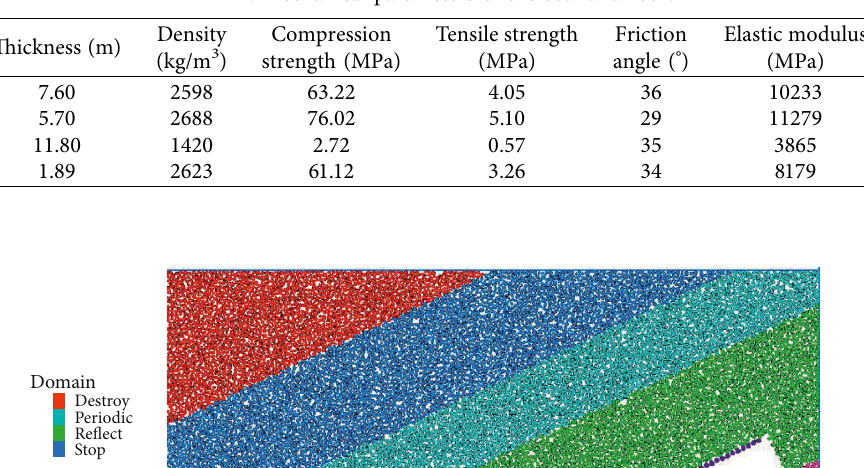
Table 2: Mechanical parameters of the coal and rock.